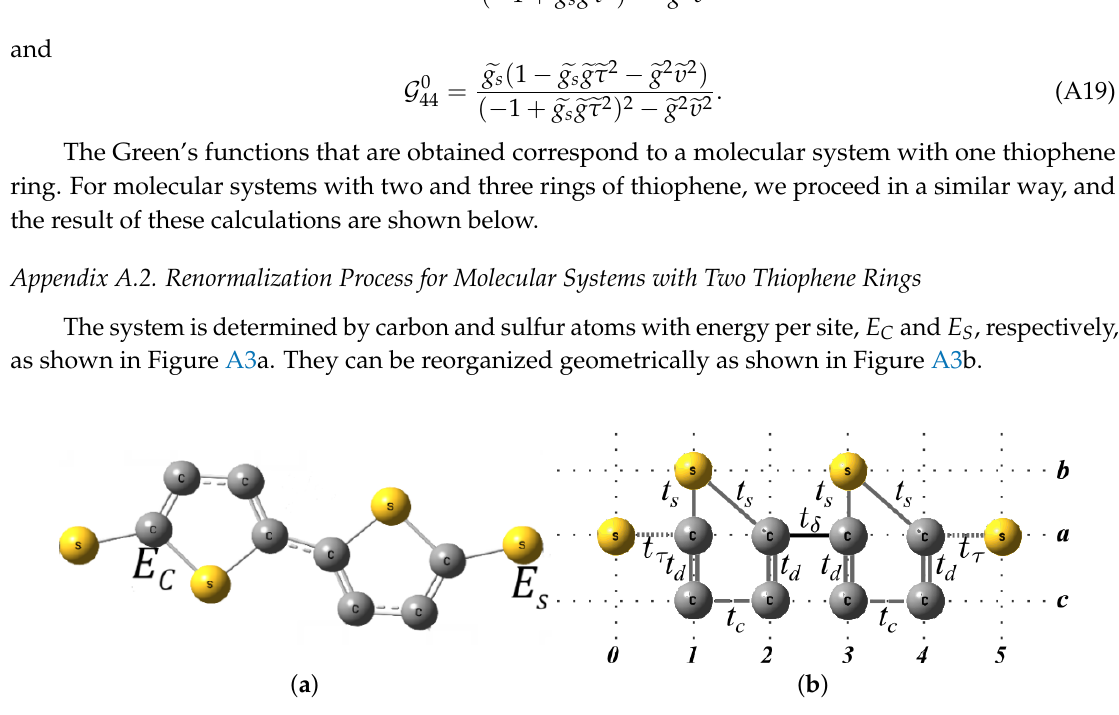
Figure A3. Molecular system ( a ) and geometric model ( b ) with two Thiphene rings without electrodes.